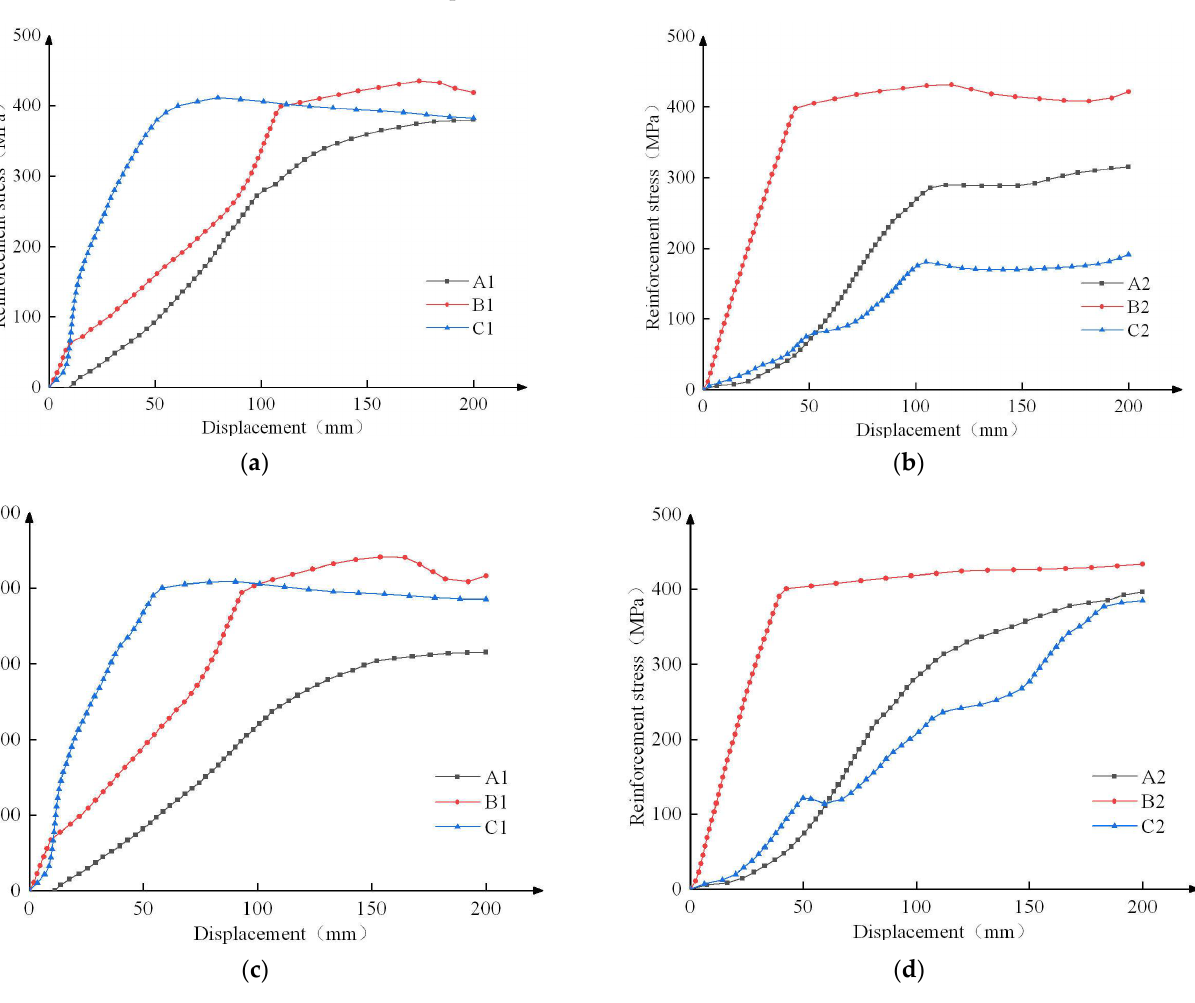
Figure 13. Stress–displacement curves for reinforcements in each specimen in specimens ZM01– Table 7. Displacements corresponding to reinforcement stresses reaching yield stress.